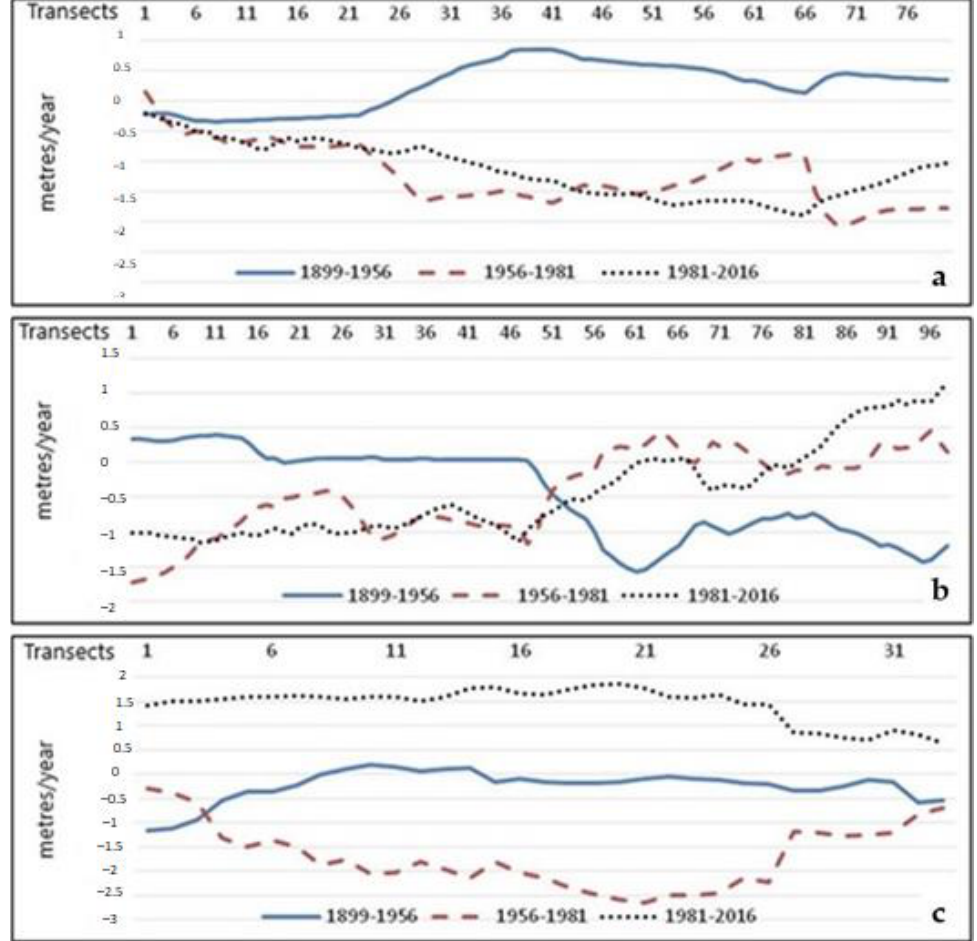
Figure 6. Shoreline variation rates evaluated along the transects in the beaches of Las Salinas ( a ), Barraca Quemada ( b ), and Punta de Algas ( c ). Source: own elaboration.